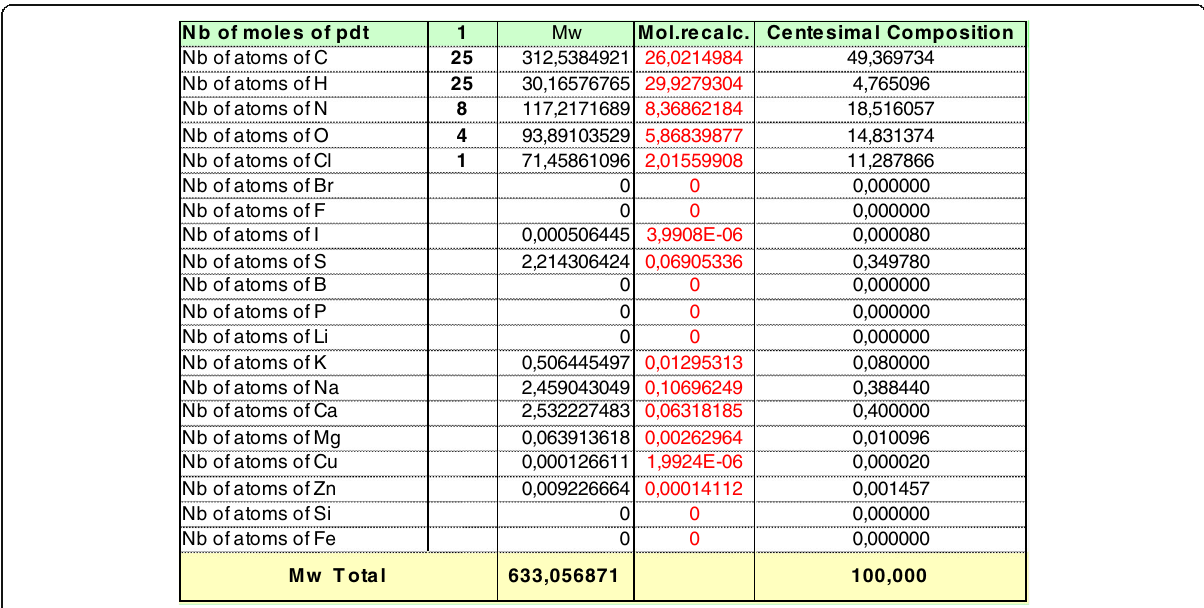
Fig. 2 User interface screenshot –– initial (2nd column), recalculated (3rd, 4th columns) raw formulae of the compound and final recalculated centesimal composition (5th column)